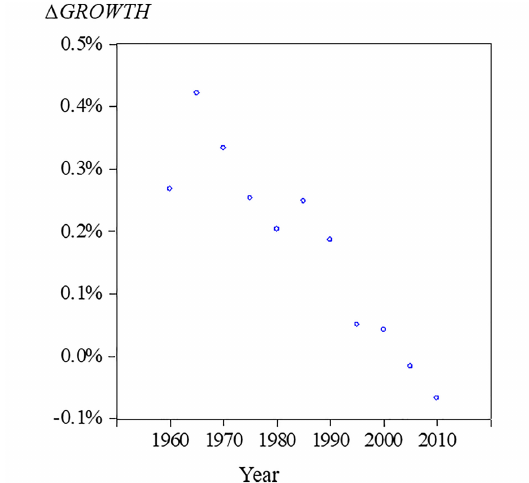
Figure 1. Time-series plot of Δ GROWTH for